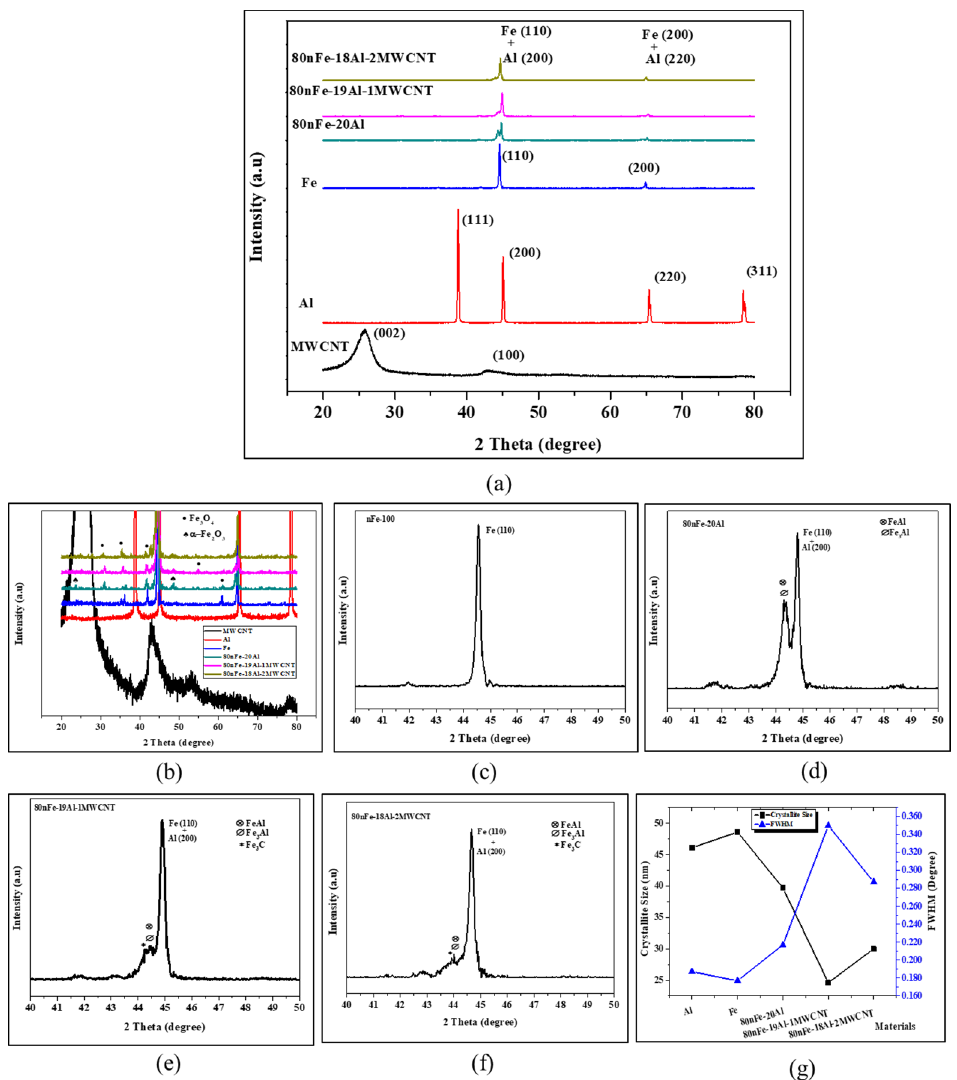
Figure 4. ( a ) XRD analysis of the composites according to the MWCNT content; ( b ) details of the XRD patterns of the materials in ( a ); ( c – f ) the zoom-up of the XRD pattern in the angular range of 40–50° for pure Fe, 80nFe-20Al, 80nFe-19Al-1MWCNT and 80nFe-18Al-2MWCNT respectively and ( g ) crystallite size and full-width-at-half maximum (FWHM) calculated based on peaks of Al(200) and Fe(110).